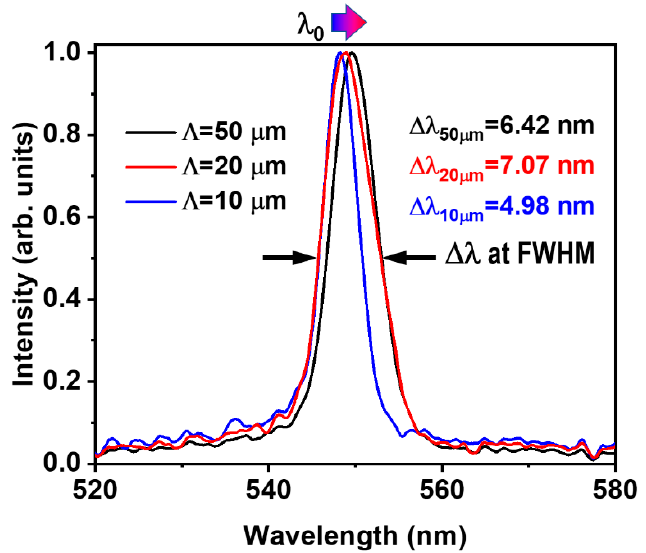
Figure 6. Comparison between the bandwidth of the random lasing spectra measured on the patterned MAPbBr 3 crystalline film at different gridding periods.